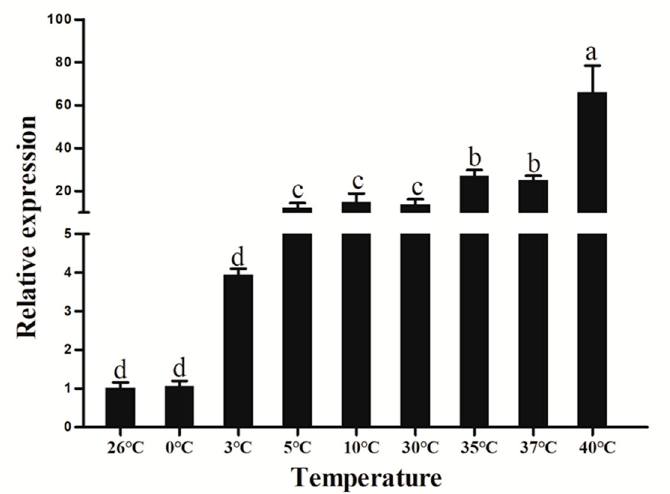
Figure 9. Relative expression levels of HvATG8 across different temperatures (n = 30 larvae in each biological replicate). Expression levels at each temperature were normalized relative to that at 26 °C. Error bars represent mean ± standard error of three biological repeats. Different letters above error bars indicate significant differences ( p < 0.05), according to one-way analysis of variance (ANOVA) followed by Tukey’s test.